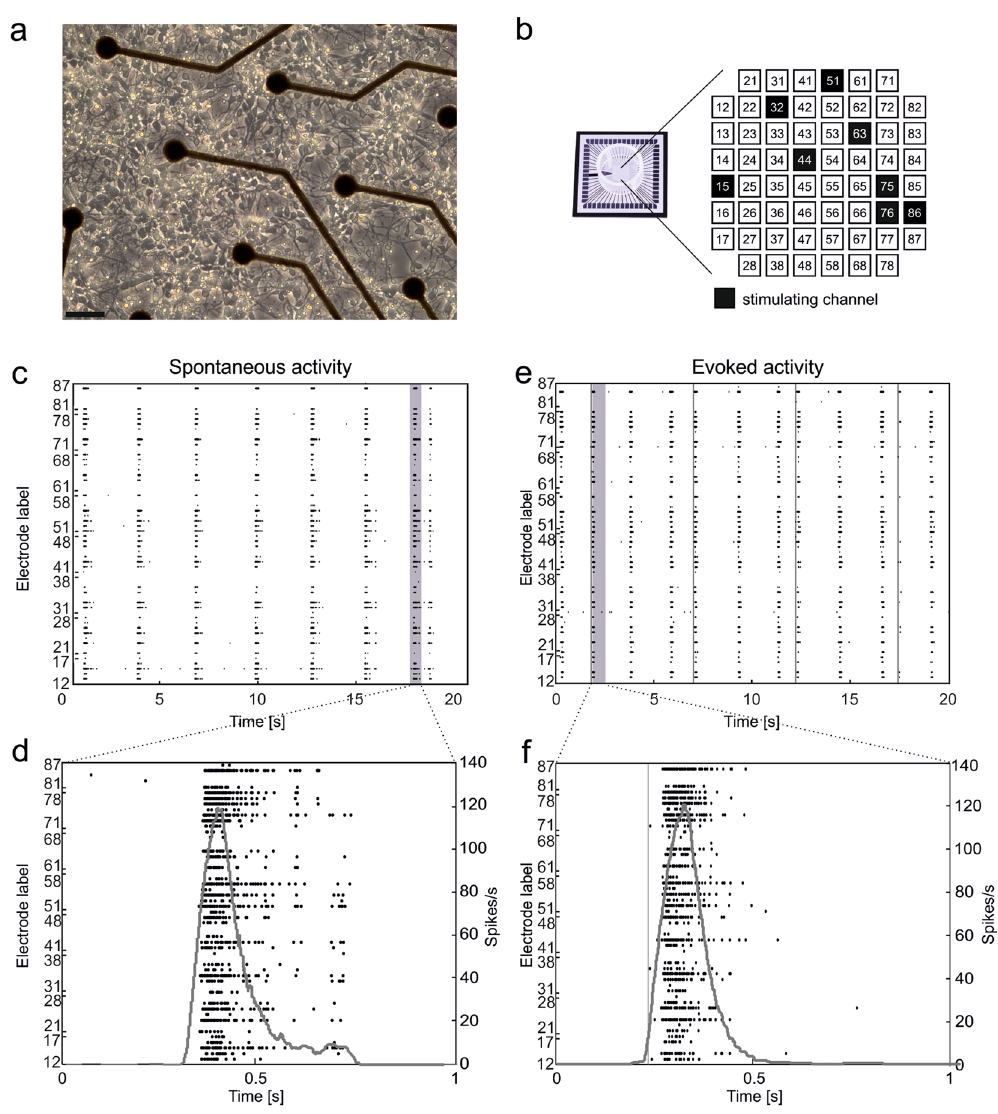
MLs show and evoke stronger and faster late responses. ML identification allowed us to deliver stimulation from either ML or follower sites (for a maximum of 8 sites, 4 of which MLs and 4 followers), to look for possible differences in the evoked activity (cf. Fig. 1b). We delivered a “test stimulus” to the culture (cf. Methods) through each of them and the evoked response was considered in a 500-ms window following each pulse. In Fig. 3a, we reported the 59 + 59 PSTH functions obtained by the stimulation of one ML electrode (32, grey traces) and of one follower electrode (63, black traces) in a representative culture. Other ML channels have been highlighted by a light grey square (i.e. channels 13, 15, 25, 42, 51, 78, 86). In this case, the stimulation from both electrodes is able to evoke a delayed network response involving most active channels. If we look closer to single PSTH functions, we can notice that in some electrodes the late response is preceded by an earlier and faster component, which does not always involve the same set of channels for different stimulated electrodes (i.e. early response). This early component, which had been previously associated to the direct activation of neurons by